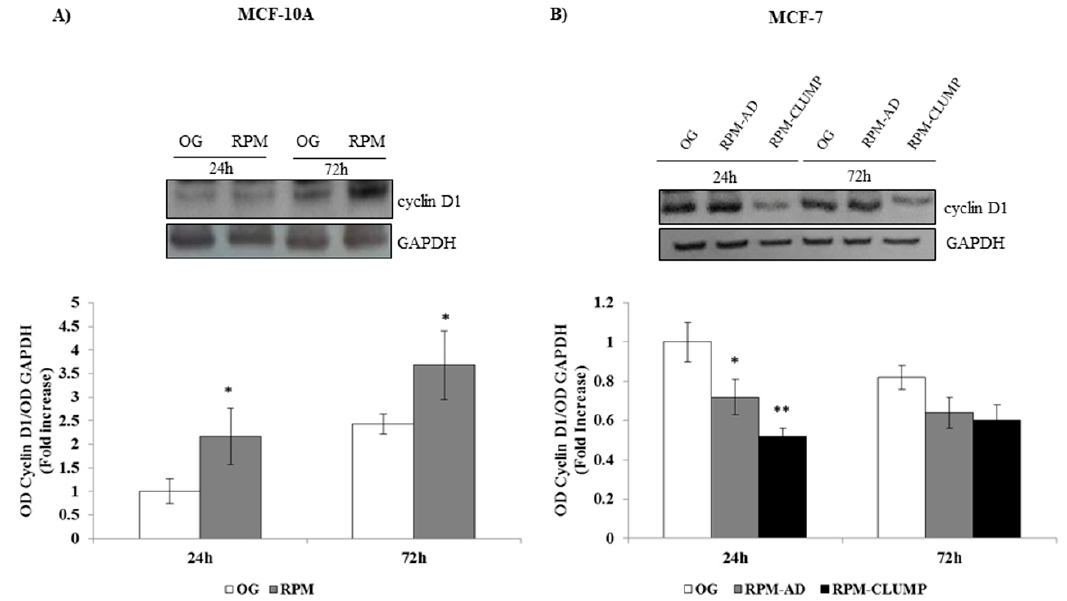
Figure 10. Immunoblot bar chart showing the expression of cyclin D1 in MCF-10A ( A ) and MCF-7 ( B ) in on-ground control cells, RPM adherent cells, and RPM cell clumps at 24 and 72 h. Columns and bars represent densitometric quantification of the optical density (OD) of a specific protein signal normalized with the OD values of the GAPDH serving as the loading control. Each column represents the mean value ± SD of three independent experiments. In MCF-10A, * p < 0.05 vs. OG by t test; in MCF-7, * p < 0.05, ** p < 0.01 vs. OG by ANOVA followed by Bonferroni post-test.